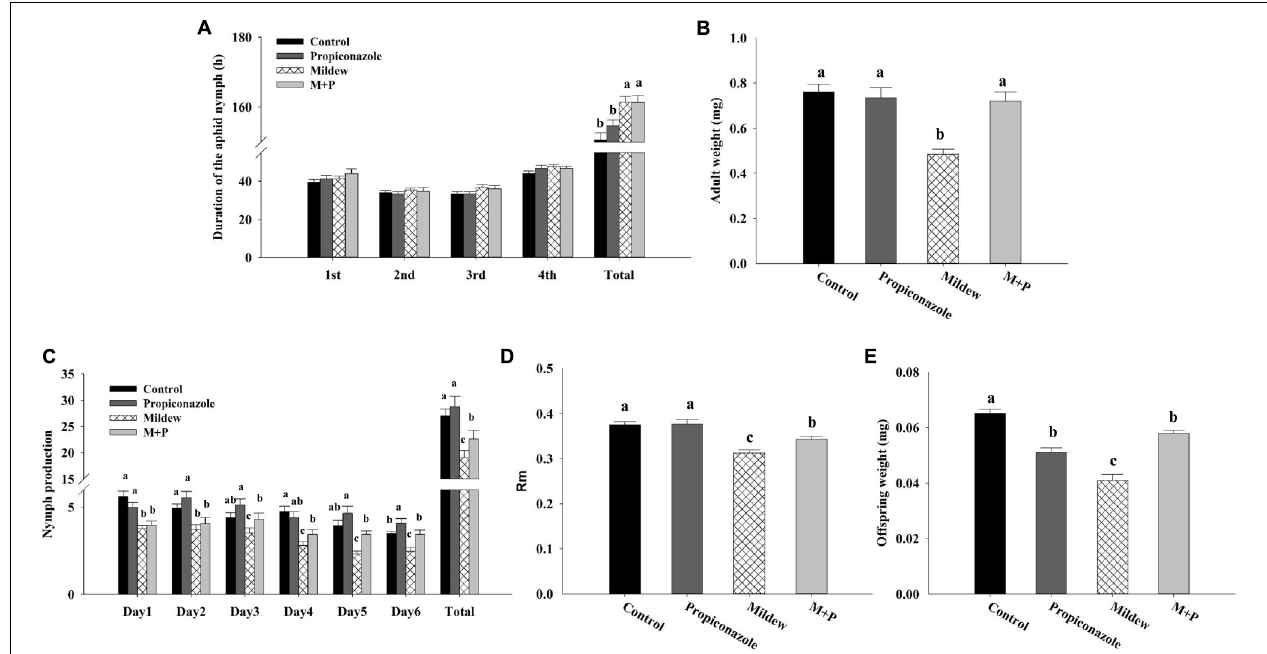
FIGURE 2 | Performance of S. avenae on different plant species. (A) Duration of the aphid nymph (days for aphids to reach the adult stage). (B) Adult weight (mg). (C) Nymph production (the number of offspring laid per adult with 6 days). (D) Rm (the intrinsic rate of increase for each aphid). (E) Offspring weight (mg). Different letters above the bars indicate significant difference among different treatments and the error bars is ± SE bars (25 biological replicates, P < 0.05, Tukey’s HSD test).